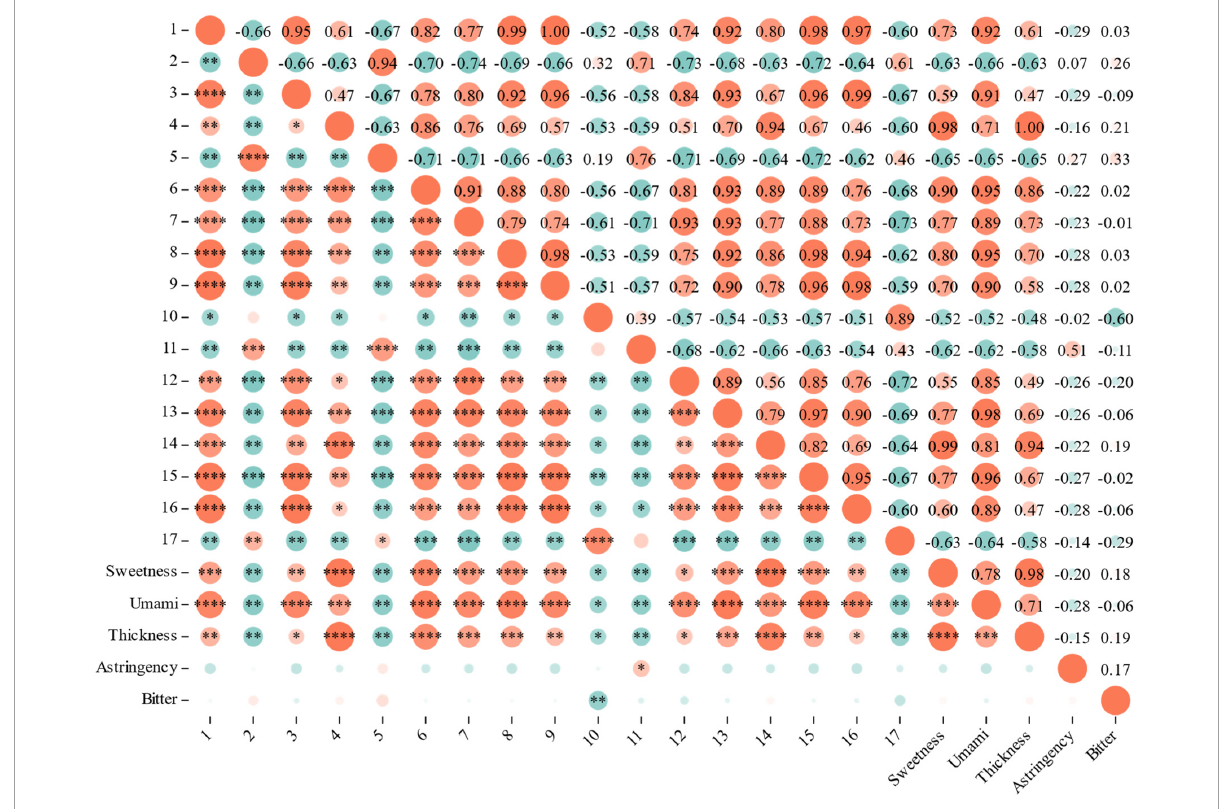
FIGURE7 Correlation analysis between sensory evaluation and differential